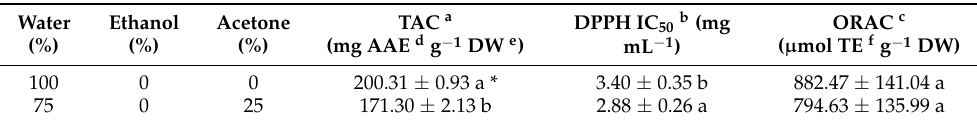
Figure 4. HPLC profiles obtained for garlic extracts using 100% water ( A ) and a binary mixture with 75% water and 25% acetone ( B ) as the solvent and UV spectra recorded online by DAD in the peaks from diallyl disulfide (1), allicin (2), and ferulic acid (3). Table 4. Antioxidant activities of garlic extracts optimized for higher contents of thiosulfinates (100% water) and phenolic compounds (75% water and 25%